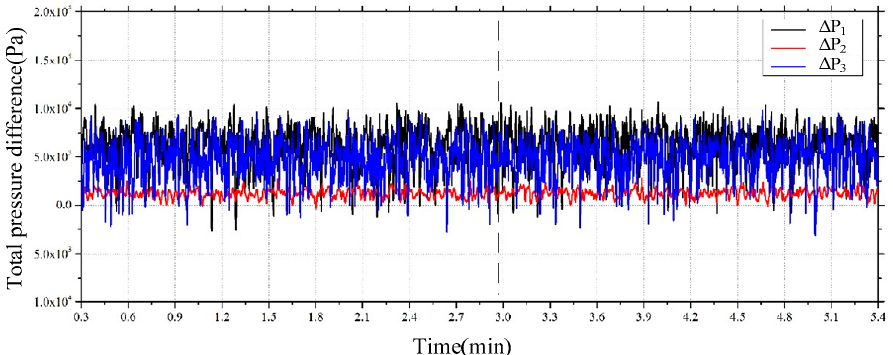
Figure 12. Variations in the total pressure differences (case 1).